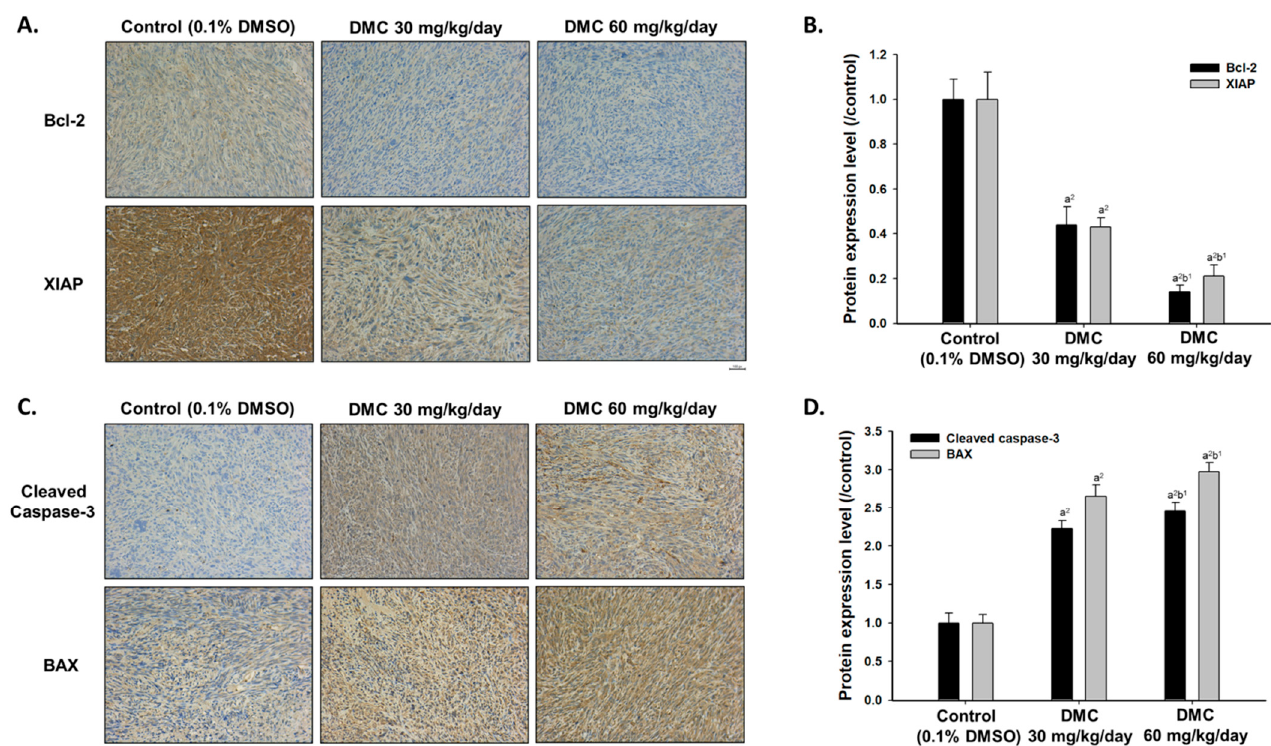
Figure 3. Apoptosis-related proteins were modulated by DMC treatment. ( A ) The IHC staining images of Bcl-2 and XIAP were observed by microscope with 100 times magnification. ( B ) Quantification results of Bcl-2 and XIAP protein levels as compared to control. ( C ) The IHC staining images of cleaved caspase-3 and BAX were observed by microscope with 100 times magnification. ( D ) Quantification results of cleaved caspase-3 and BAX protein levels as compared to control. (a 2 < 0.01 vs. control; b 1 p < 0.05 vs. DMC 30 mg/kg).